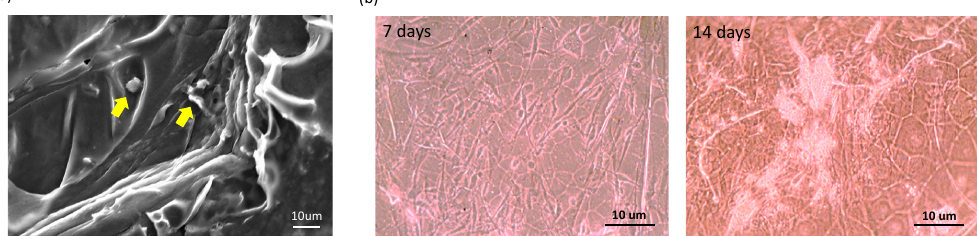
Figure 3. In vitro biocompatibility of human adipose stem cells (hASCs) seeded on the gelatin scaffold. ( a ) Scanning electron microscopy (yellow arrow: hASCs); ( b ) the growth of hASCs with time.